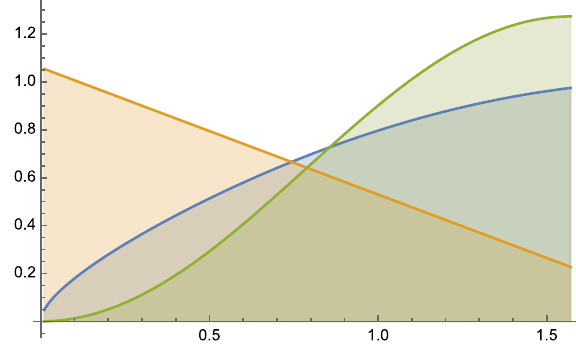
Fig. 8 Example 3: f ( x )/µ (in blue) superimposed on the two pdfs used for MIS